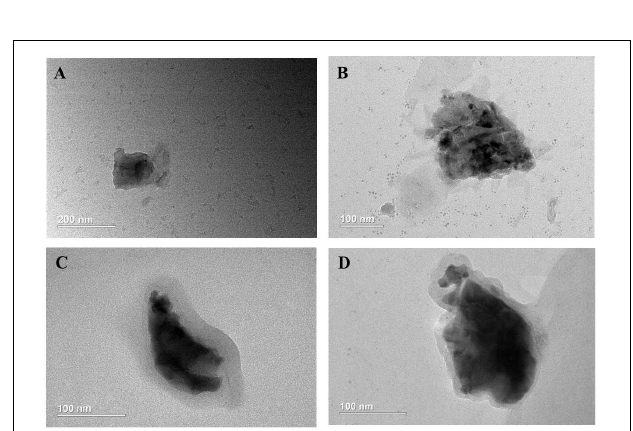
FIGURE 2 | Characterization of BP NSs. TEM images of (A) BP NSs; (B) BP@PDA NSs; (C) BP@PDA-PEOz; (D) BP@PDA-PEOz-BTZ.